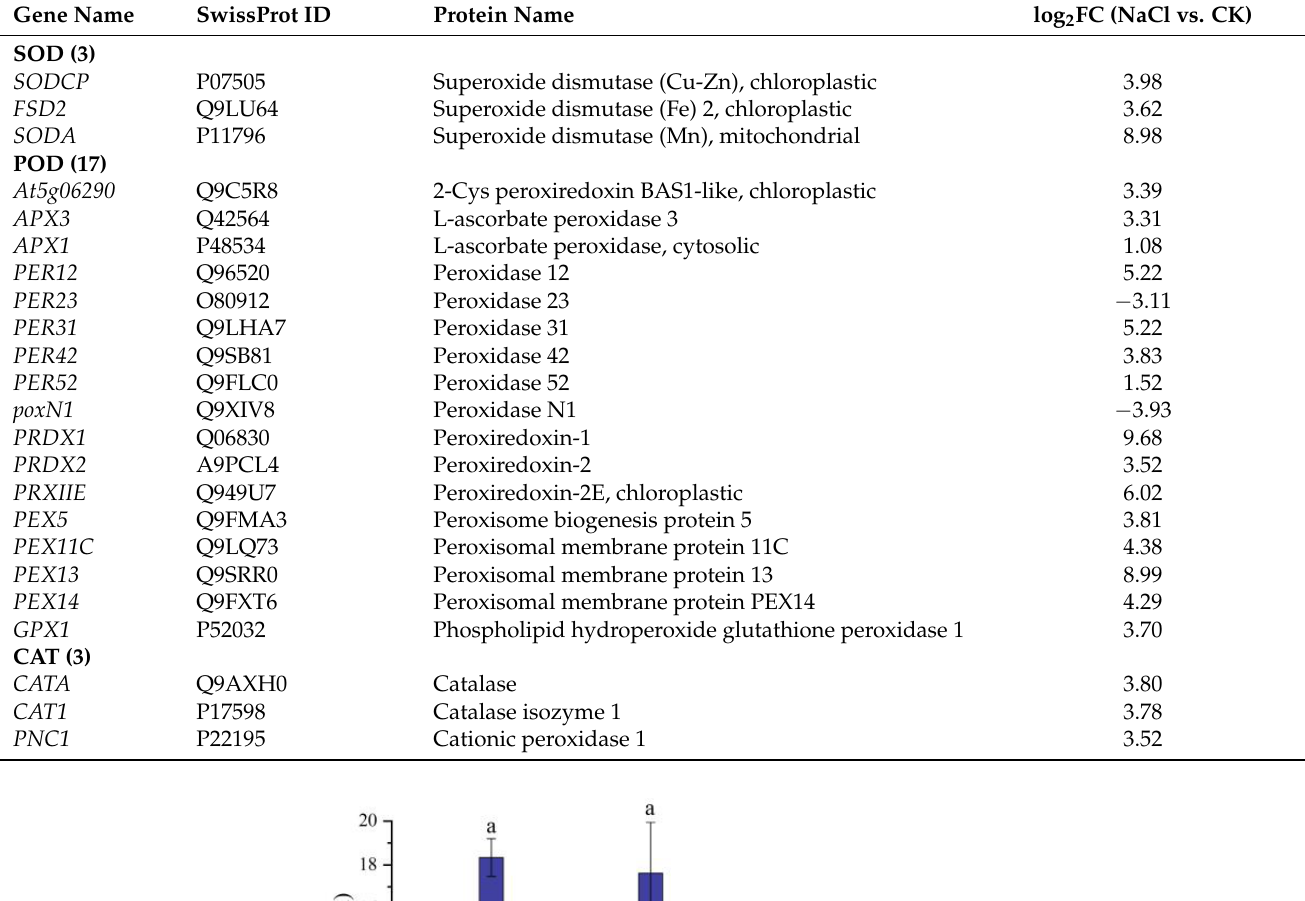
Table 3. Twenty-three genes directly associated with antioxidant enzymes at the 300 mmol/L NaCl vs. CK.